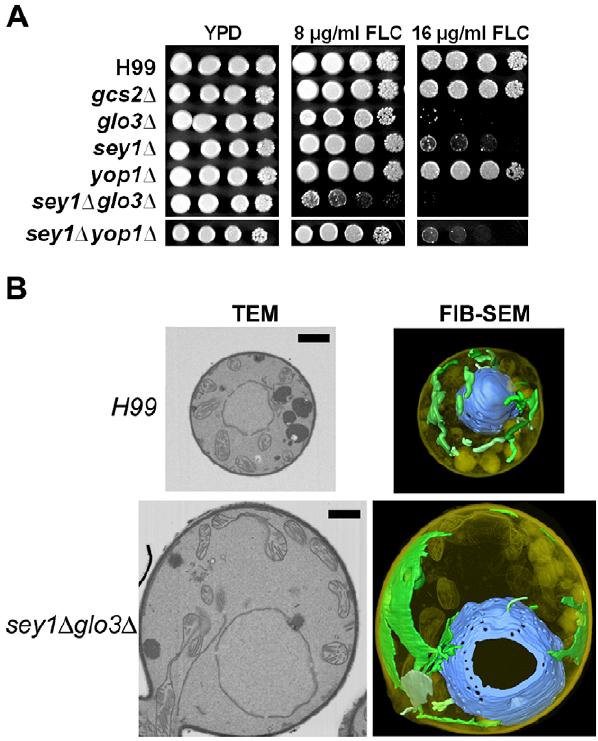
Figure 2. Importance of ER integrity and resistance to FLC. (A) Spot assay showing FLC sensitivity of the strains with deletion of ER integrity-associated genes. (Adapted from Ngamskulrungroj et al. [27,30].) (B) Focused ion beam-scanning electron microscopy (FIB-SEM) shows severe perturbation of ER network in a sey1 D glo3 D double deletant compared to H99. ER and nuclei were pseudocolored green and blue, respectively (right column). Left column shows orthoslices representing central sections by transmission electron microscopy. The cells of sey1 D glo3 D are considerably larger than the wild type or deletant of a single gene. Bar=1 m m. (Adapted from Ngamskulrungroj et al